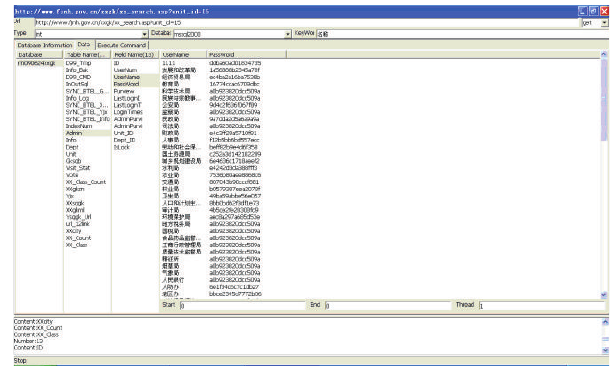
Figure 17: Content of the database obtained from